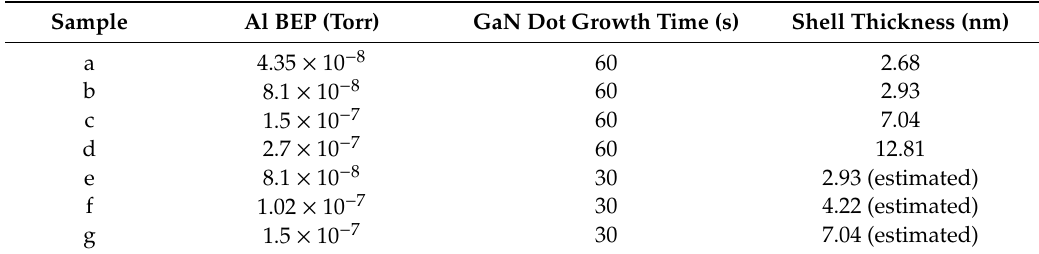
Table 1. Summary of the samples used for comparison experiments and the related parameters.